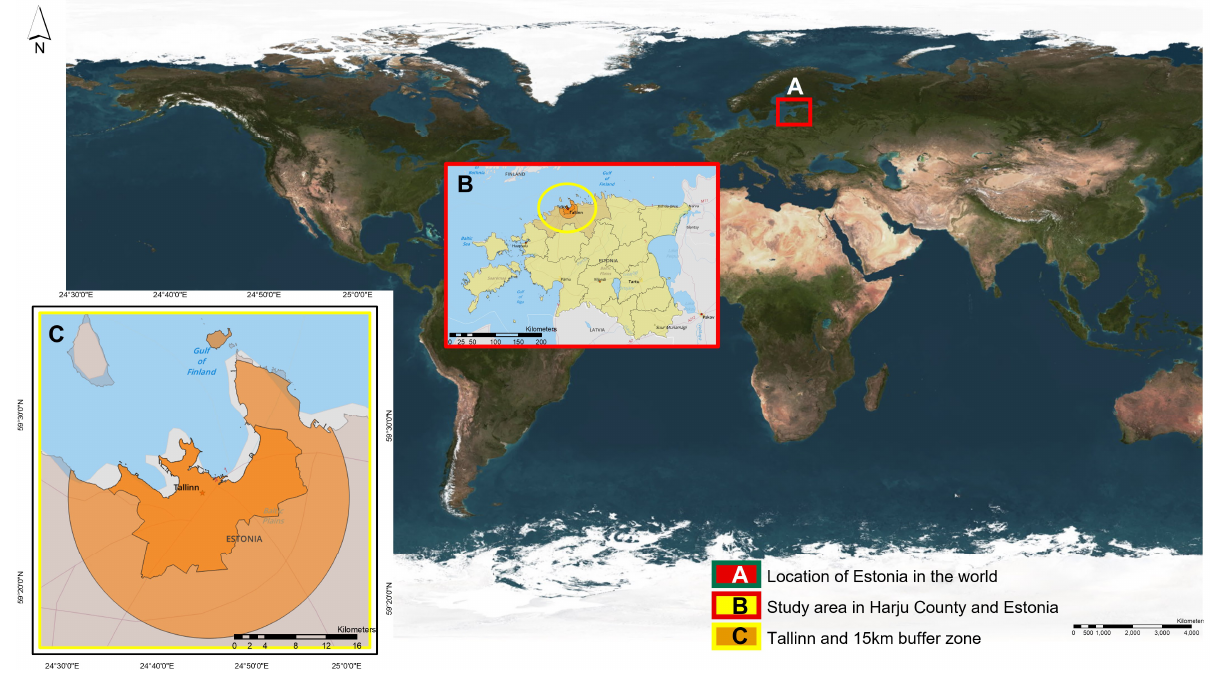
Figure 1. Study area: Tallinn and 15 km buffer